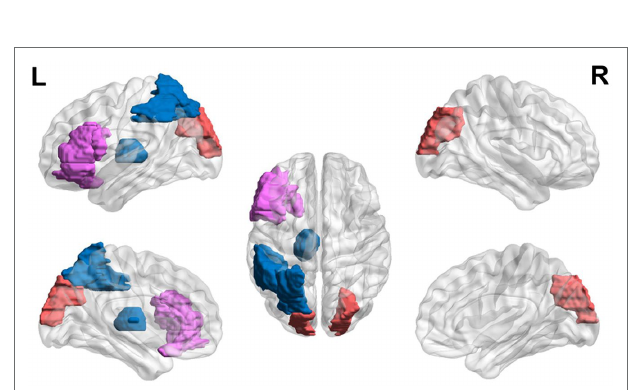
FIGURE 4 | Neural circuit dysfunction related to reading circuits in adults (ages 22+) with dyslexia. Decreased activation in the left thalamus (Díaz et al., 2012), the left inferior frontal gyrus (Wimmer et al., 2010), and the left parietal lobule (Wimmer et al., 2010) and increased activation in the left inferior frontal gyrus (Karni et al., 2005) and bilateral superior occipital gyri (Wimmer et al., 2010) related to EF in adults ages 21 and up with dyslexia. Red represents areas of hyperactivity, blue areas of hypoactivity, and purple areas where papers have reported hyperactivity and hypoactivity. Data are presented in sagittal and axial views in the left and right hemispheres (L = left and R = right) over a glass brain. Regions were defined based on AAL atlas (Tzourio-Mazoyer et al., 2002). Image created using the BrainNet Viewer (Xia et al.,